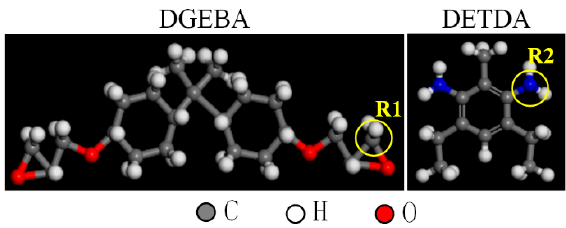
Figure 1. Molecular models for DGEBA (diglycidyl ether of bisphenol A) and DETDA (diethyl toluene diamine).